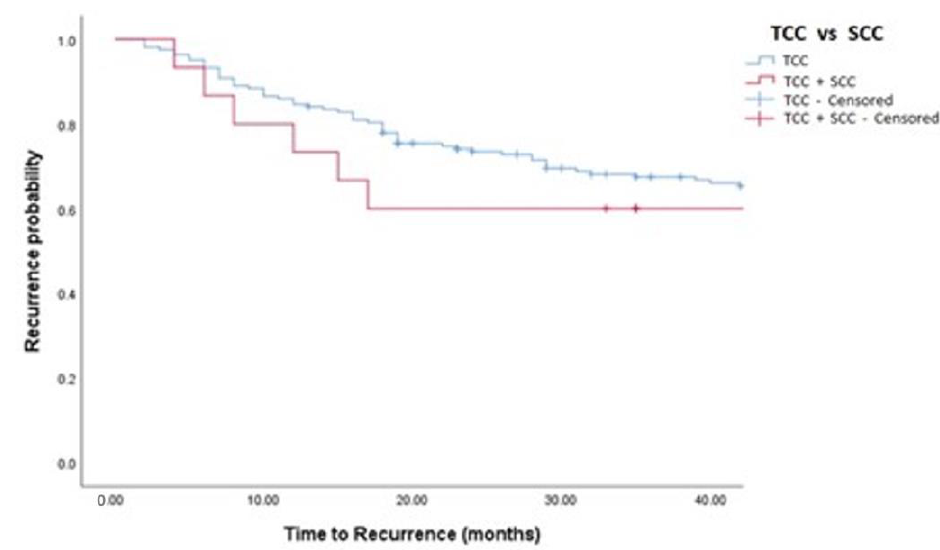
Figure 1. Kaplan – Meier analysis showing estimates of disease recurrence in TCC and TCC + SCC patients treated with MMC (log-rank p = 0.448). TCC = Conventional Urothelial non-muscle-invasive bladder cancer. SCC = Squamous Cell Carcinoma.